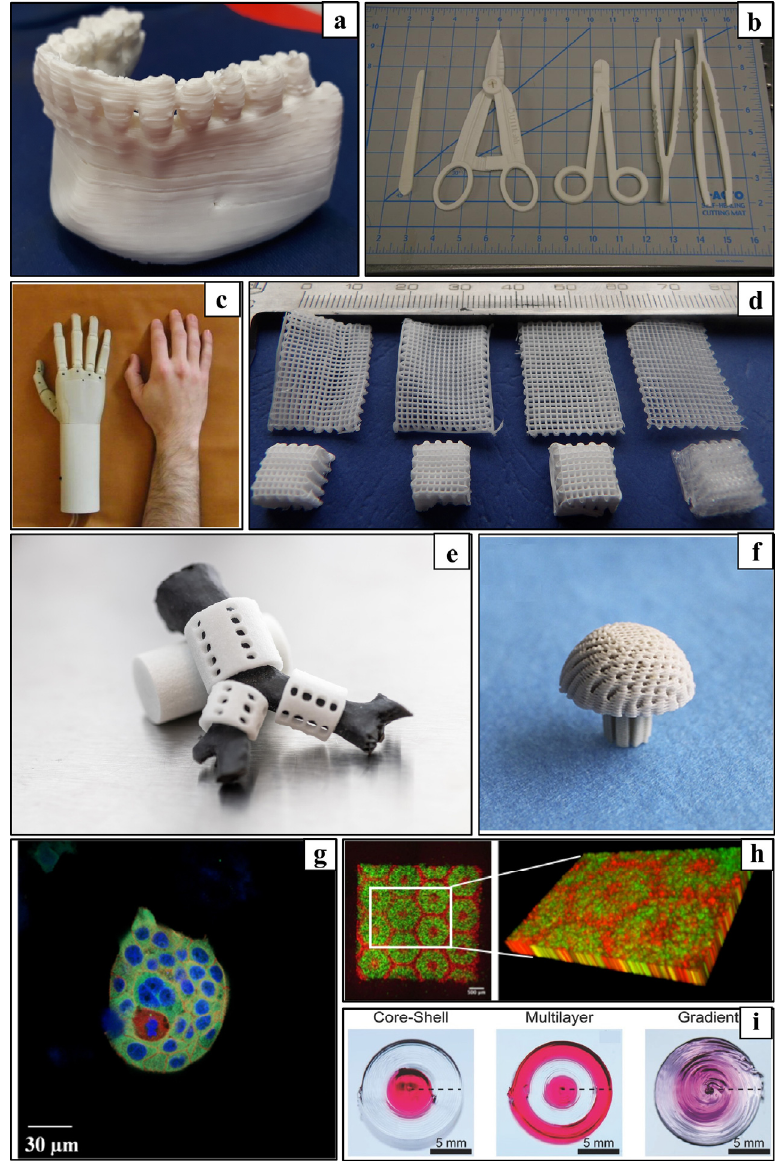
Figure 4. Representative examples of biomedical AM applications: ( a ) 3D anatomical models, ( b ) specially designed surgical instruments, ( c ) exo-prostheses, ( d ) 3D printed surgical implants, ( e ) surgical implants made of biodegradable materials, ( f ) scaffold-based tissue engineering, ( g ) 3D- microstructured tissue models for visualization, ( h ) advanced organ-on-a-chip integration, ( i ) time- dependent drug release system [24].